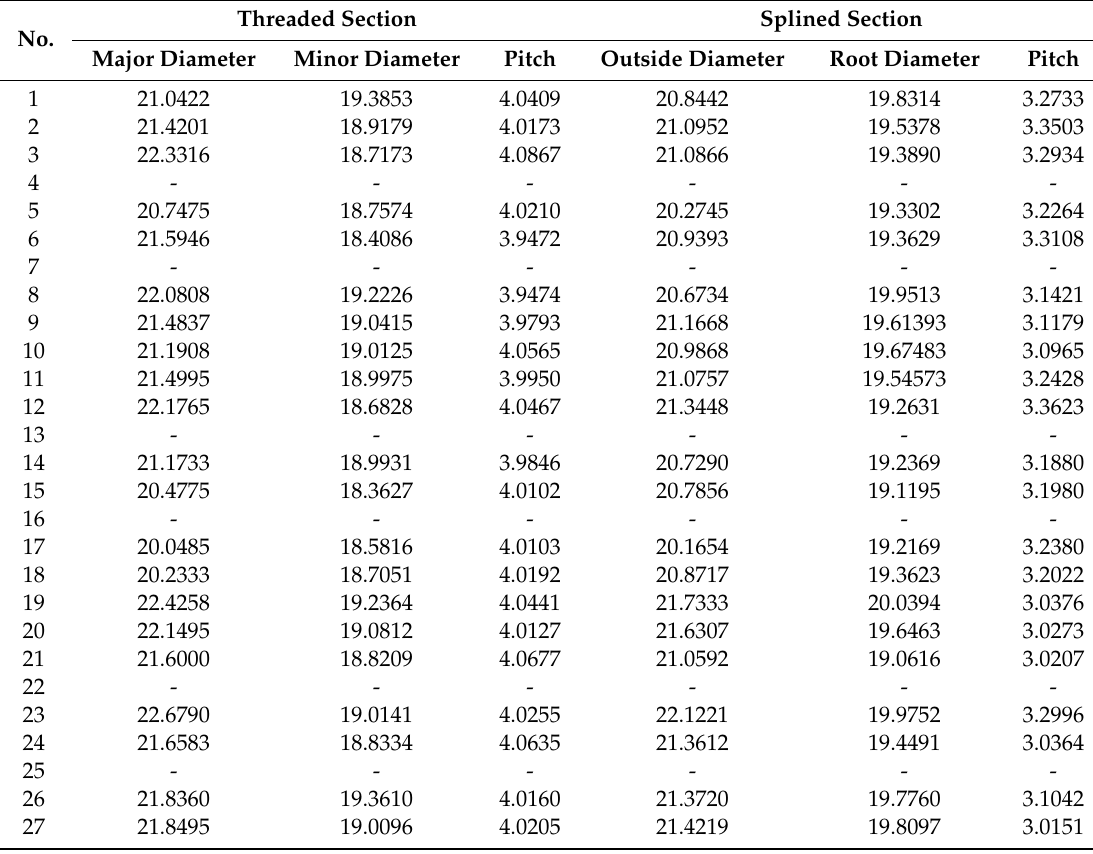
Table 6. Measured data (unit: